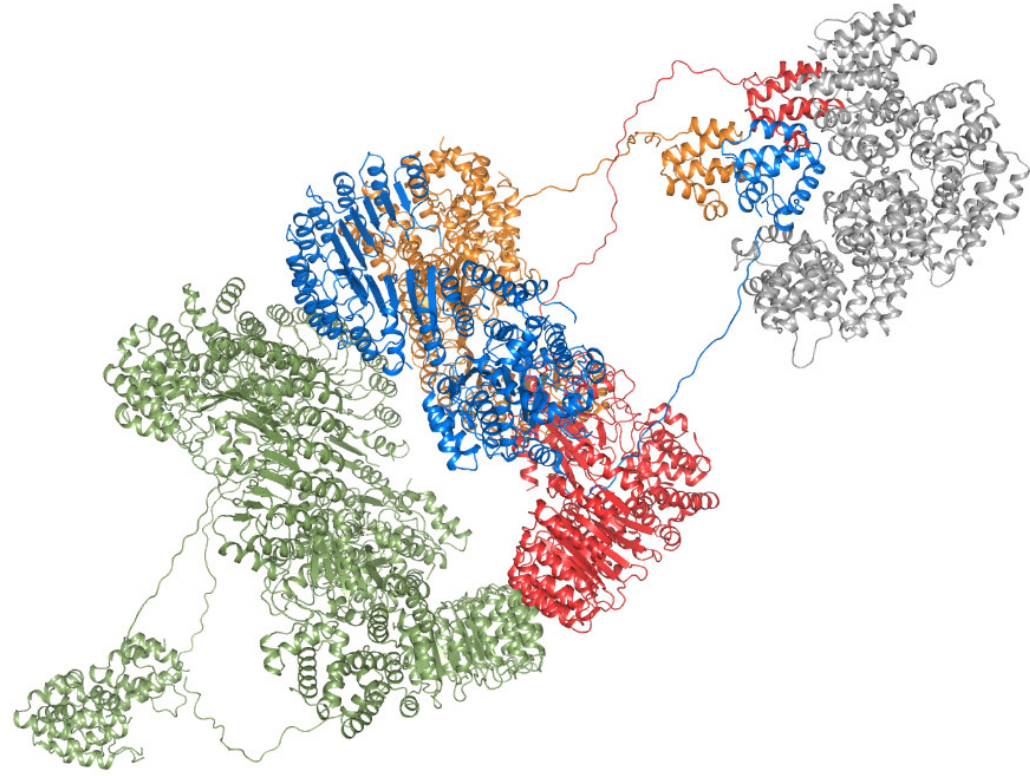
Figure 4. Model of NLRP3-mediated generation of ASC filaments. A hypothetical hexamer of full- length NLRP3 is shown in cartoon representation with the protomers of one trimeric ring colored in orange, red, and blue, respectively. The pyrin domains have been attached to the N-termini of the protomers of the PYD-deleted hexamer (PDB ID 7PGU) via their flexible linkers in a hypothetical conformation. The ASC-filament is shown in